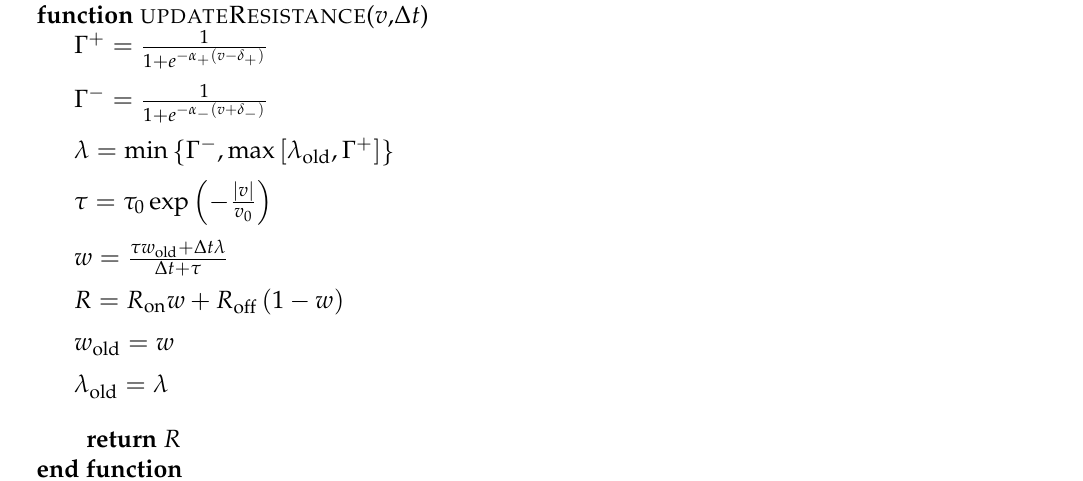
Algorithm 3 Model implementation in Arduino Due: Numerical